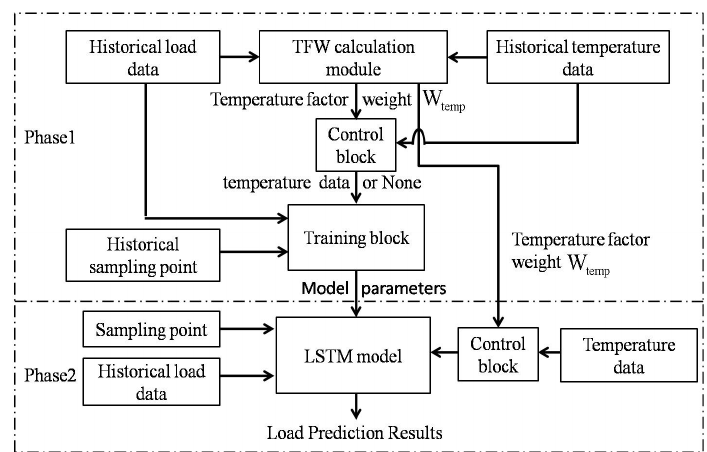
Figure 6. Block diagram of the proposed